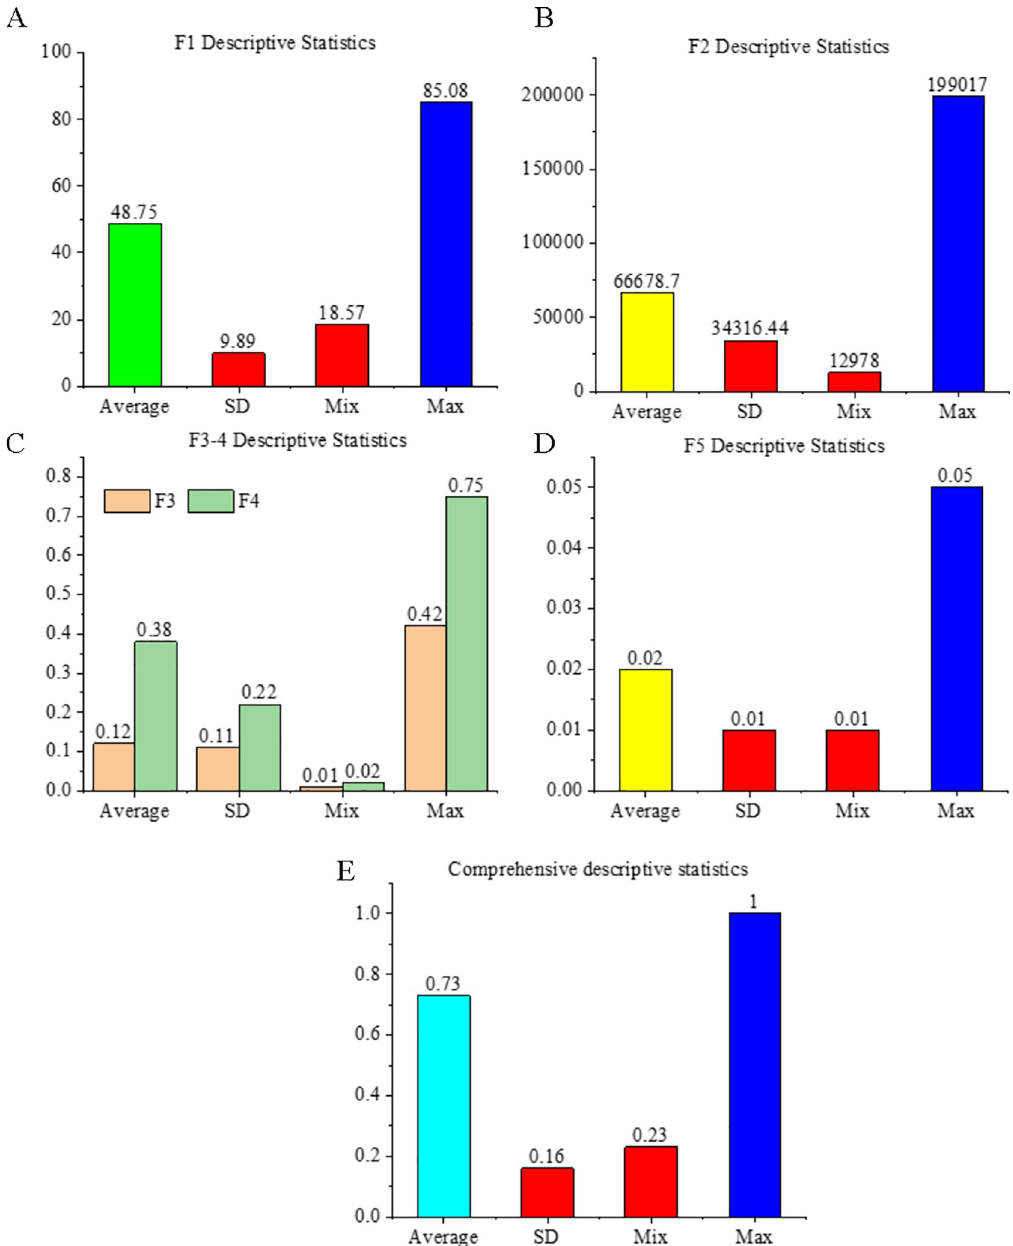
Fig 4. Descriptive statistics of comprehensive efficiency and influencing factors. Note: In Fig 4, F1 to F5 respectively represent the economic environment, economic structure, number of talents, high-tech IDZ’s regional scale, capital investment, and comprehensive